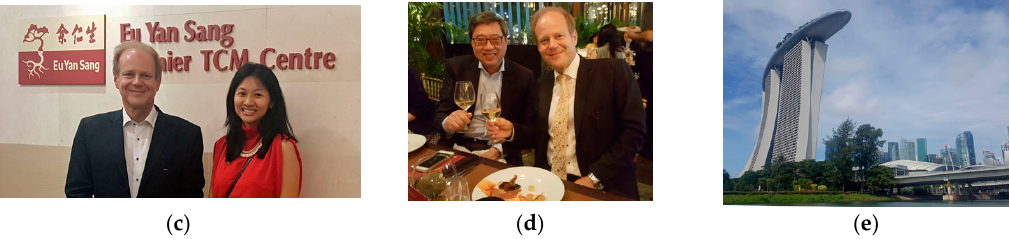
Figure 18. Eu Yan Sang ( a – d ) Australia–China–Hong Kong–Indonesia–Macau–Malaysia–Singapore–USA.